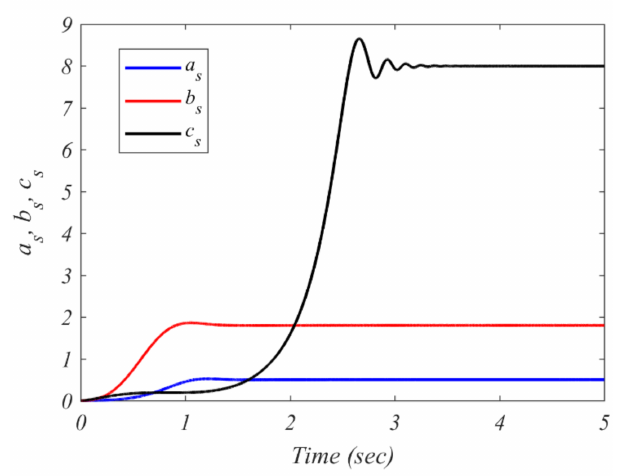
Figure 9. Estimation of uncertain slave parameters corresponding to master trajectories. As can be seen from Figure 9, that the uncertain slave parameters, a s and b s , are rapidly estimated corresponding to the master parameter a m and b m , respectively (in less than 1.5 s), which is an exact match to the time duration of the synchronization errors to reach